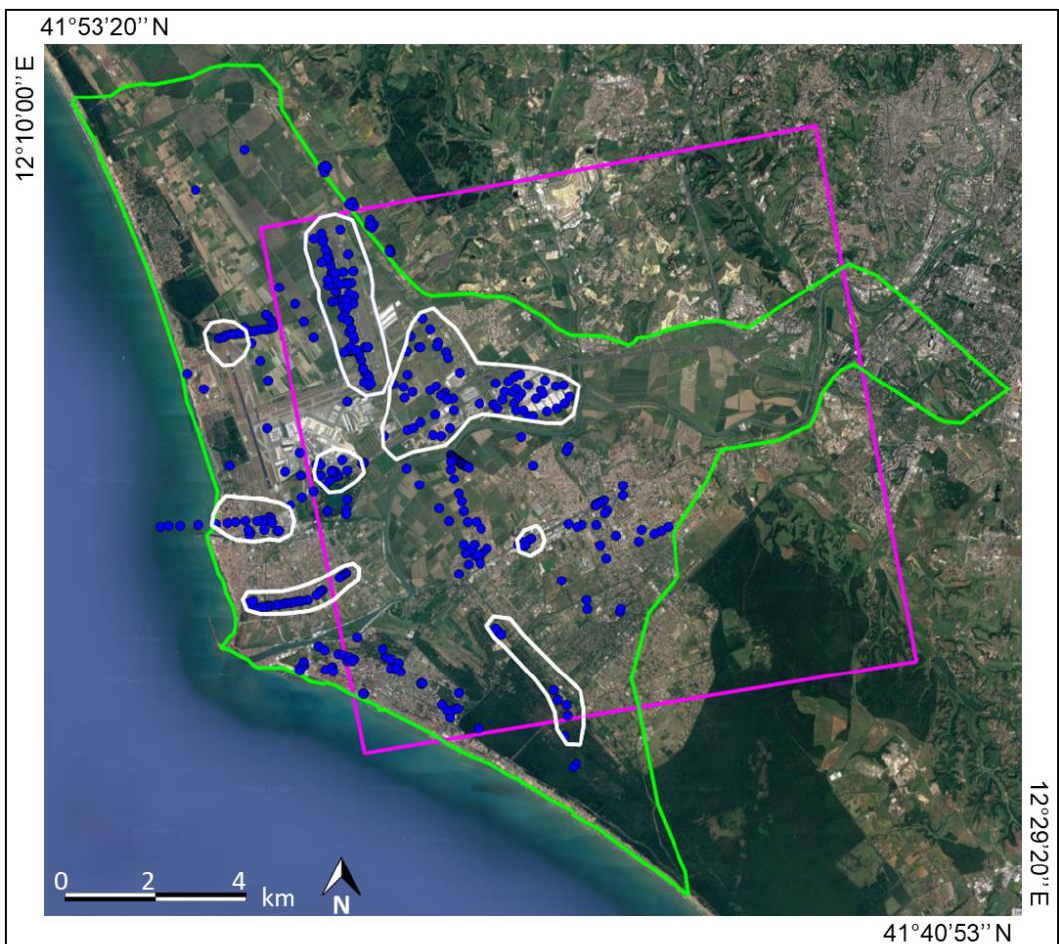
Figure 3. Location of the collected boreholes (blue dots). The magenta polygon outlines the extent of the region analysed via ascending COSMO-SkyMed imagery; the green polygon represents the extent of the region analysed via ERS-ENVISAT data; the white polygons outline the eight selected sub-regions for the high-resolution analysis.